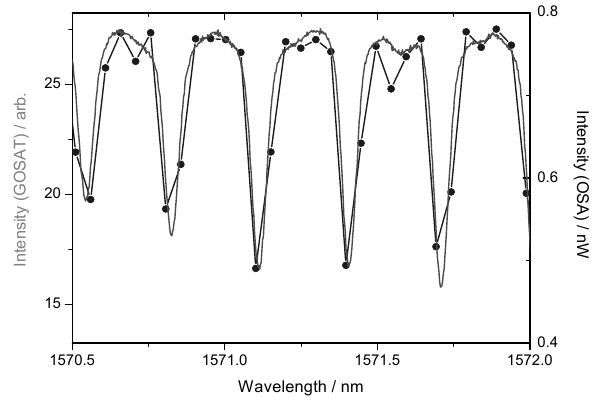
Fig. 4 Fig. 4. Parts of CO 2 photoabsorption spectra measured by OSA and FTS onboard GOSAT. OSA: smooth curve; GOSAT: line with